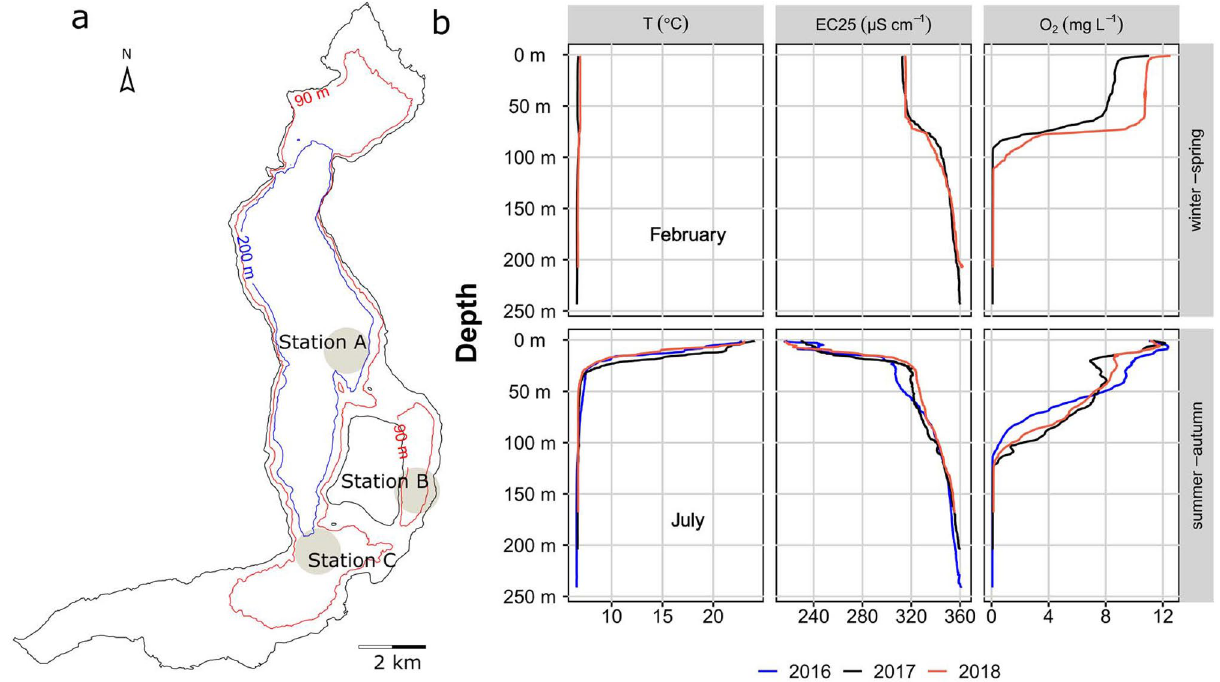
Figure 1. Map and selected characteristics of Lake Iseo. Panel ( a ) depicts the shoreline of Lake Iseo along with two isodepth lines (90 m in red and 200 m in blue). Map was created by use of R software (Version 3.4.3) from published bathymetric data 47,77 . Labeled dots indicate sites sampled throughout the campaigns. Panels ( b ) show temperature (T), electrical conductivity (as 25°C, EC25) and dissolved oxygen (O 2 ) distribution in the water column between 2016 and 2018 in the deep basin (station A). Upper and lower row of panels show profiles for the isothermic (February), and summer stratified condition (July),